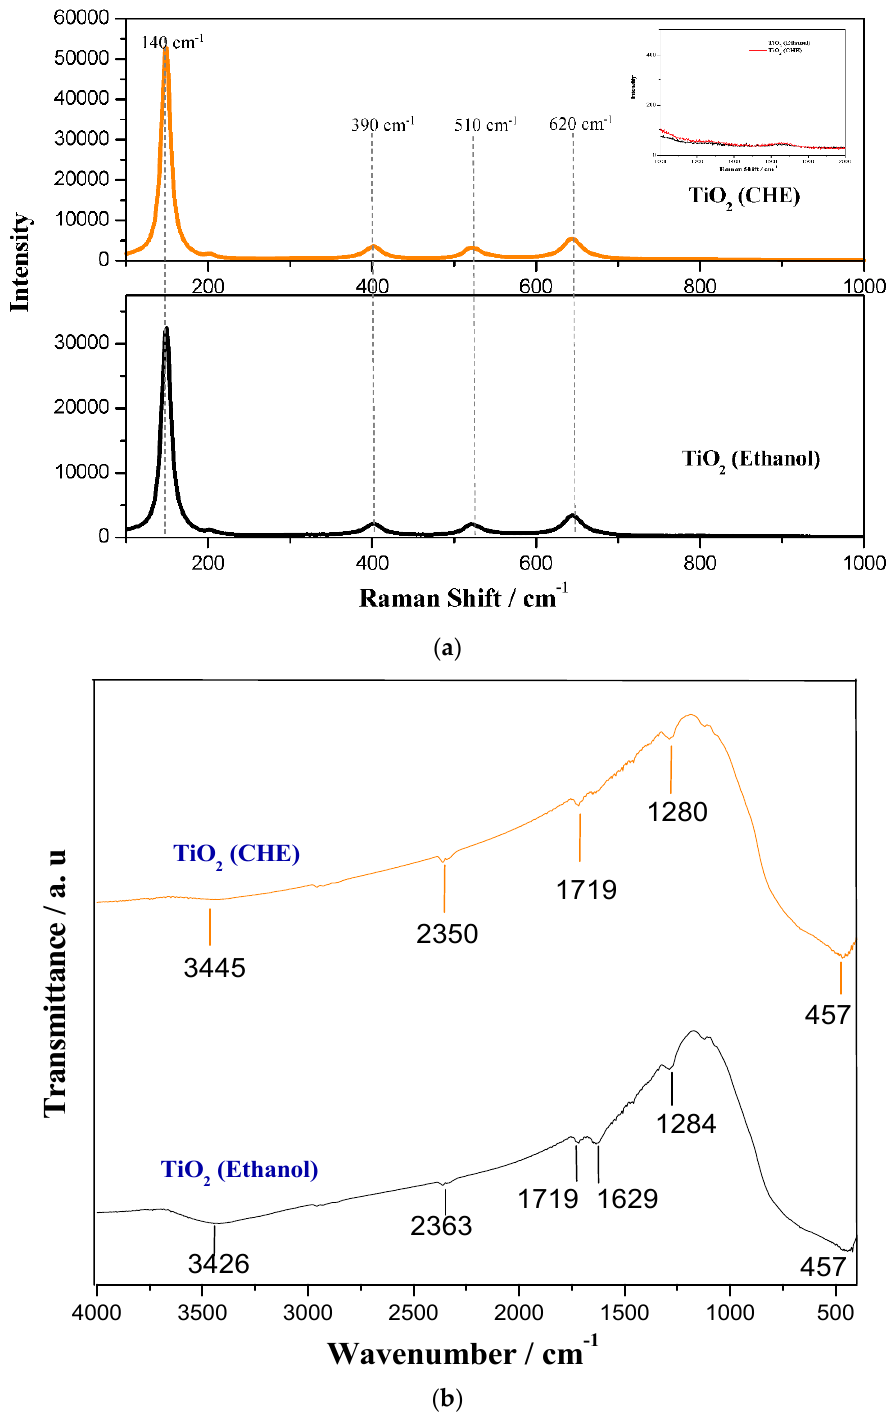
Figure 5. Raman spectra ( a ) and FTIR spectra ( b ) of the as synthesized TiO 2 nanomaterials. The inset of ( a ) shows the enlargement for the area of carbon.